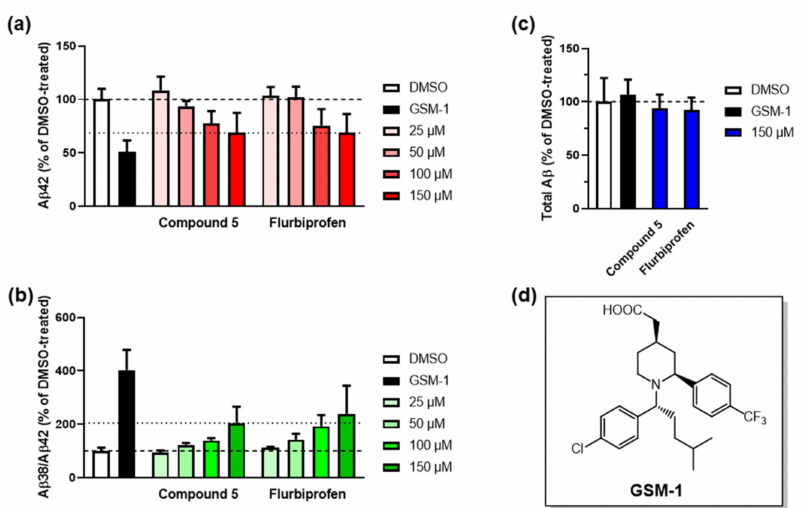
Figure 1. Compound 5 is a GSM with similar potency as flurbiprofen: ( a ) dose-dependent lowering of A β 42, ( b ) dose-dependent increase in γ -secretase processivity, ( c ) stable maintenance of total A β levels (sum of measured A β 38, A β 40, and A β 42) at the highest effective concentration. Data in ( a – c ) are represented as the mean ± SD ( n = at least 6 biological replicates), the concentration of GSM-1 in all experiments was 1 µ M. A β 42 data in ( a ) are represented as ratio of total A β . ( d ) Structure of GSM-1